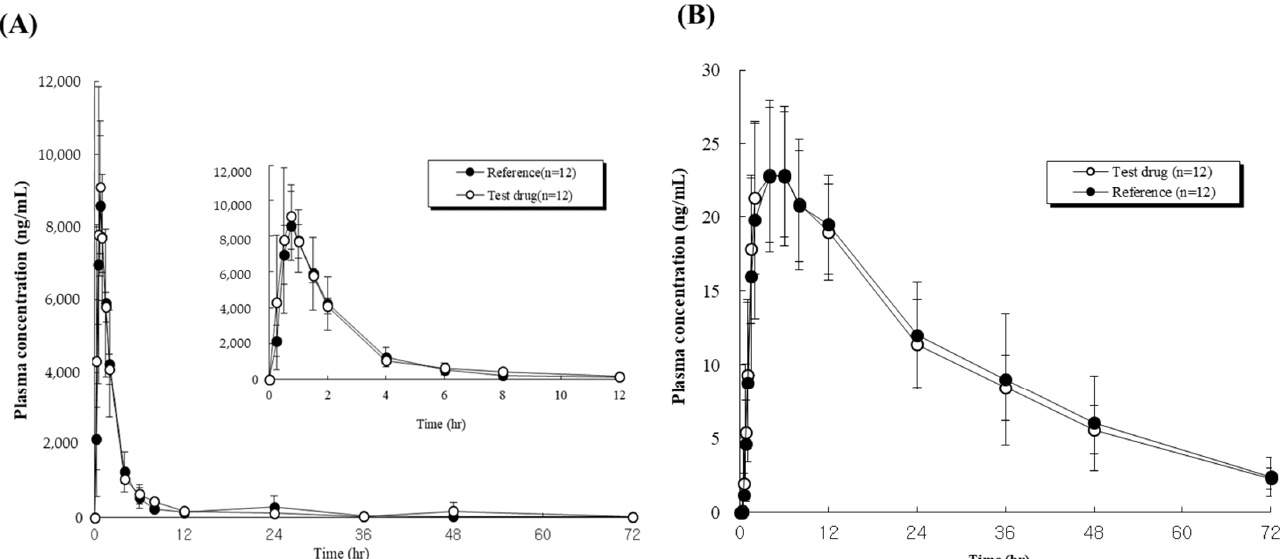
Figure 6. ( A ) Plasma concentration-time profiles of Twynstar ® and TA tablets at a dose of 80 mg telmisartan base in beagle dogs, and ( B ) Plasma concentration-time profiles of Twynstar ® and TA tablets at a dose of 5 mg amlodipine base in beagle dogs. Data represent the mean ± standard deviation (SD, n = 12).